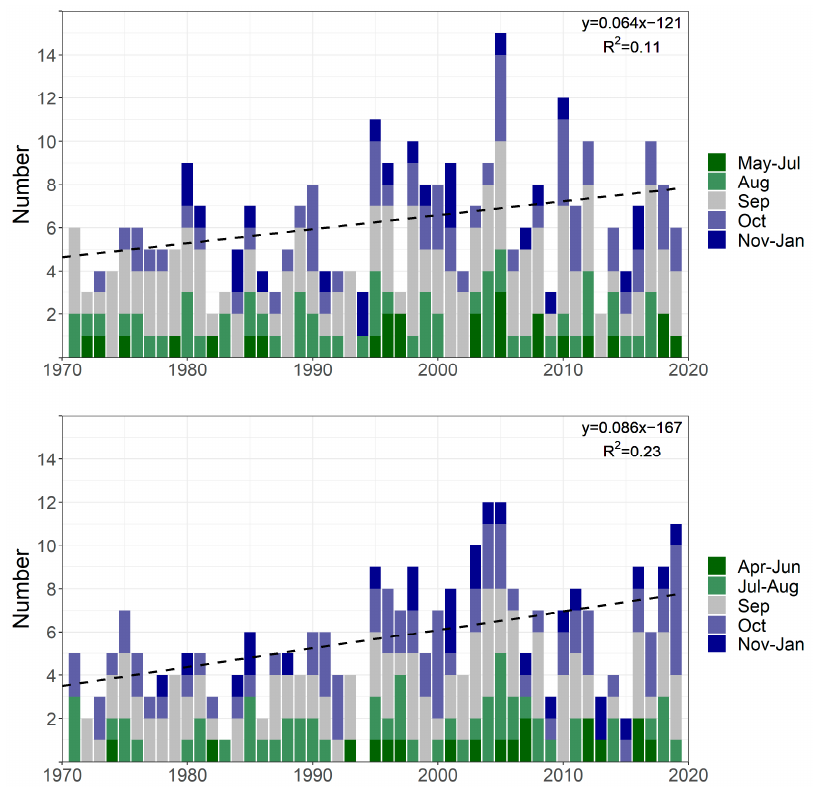
Figure 2. Total annual abundance of TCs ( top graph) and ETCs ( bottom graph) and proportion of their occurrence by month (1970–2019).